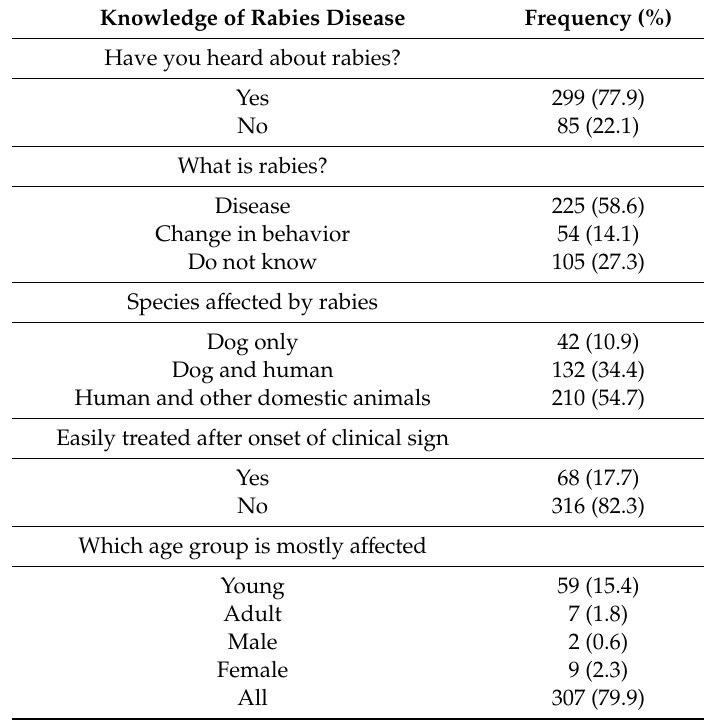
Table 2. General knowledge of the study participants towards rabies (N = 384),